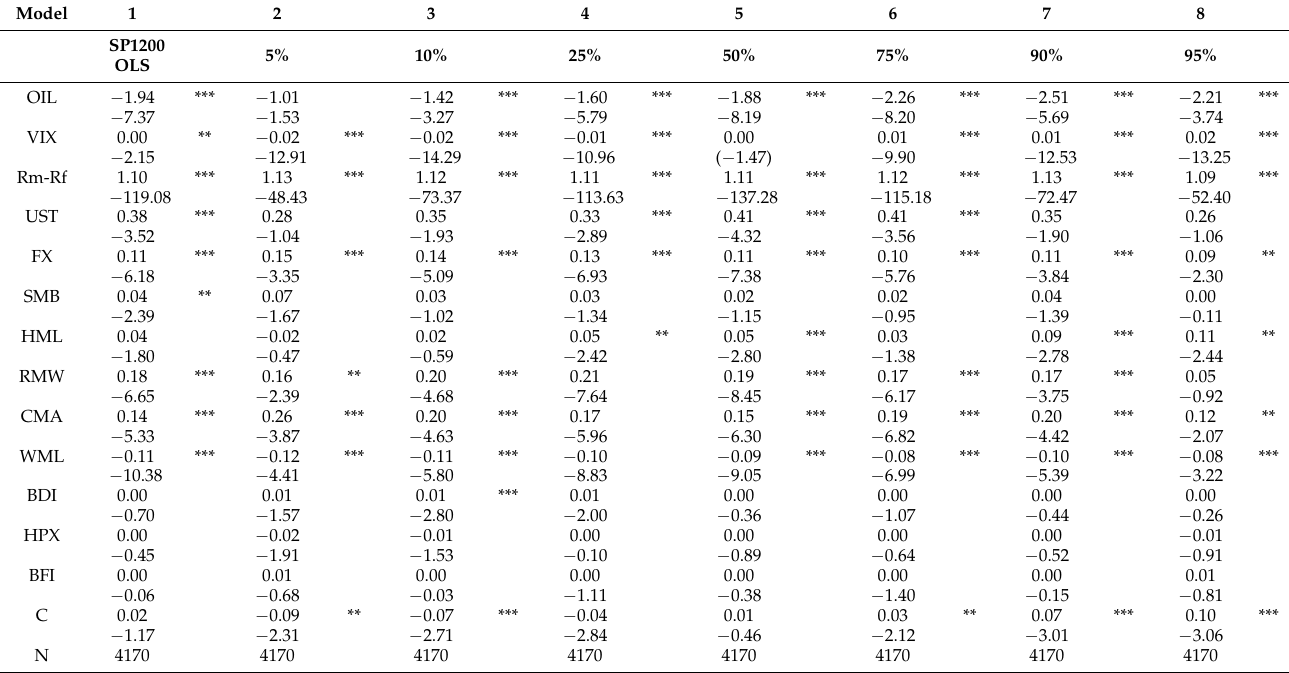
Table 11. The performance model applied to S&P (SP) 1200 Industrial firms